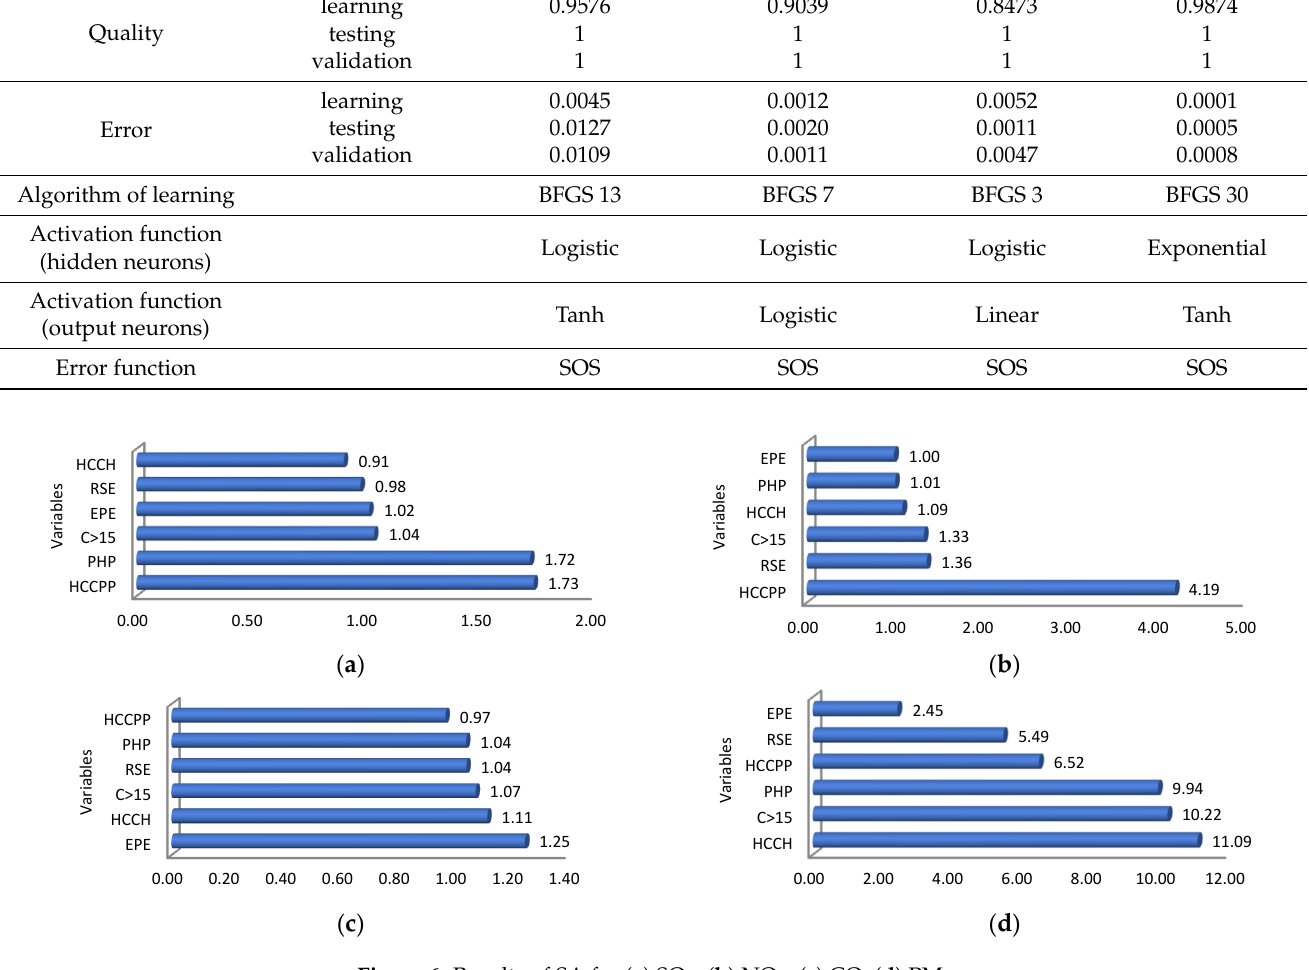
Figure 6. Results of SA for ( a ) SO 2 ; ( b ) NO x ; ( c ) CO; ( d ) PM. To verify the effectiveness of the models created, the actual data were compared with the data obtained through modelling (Figure 7).